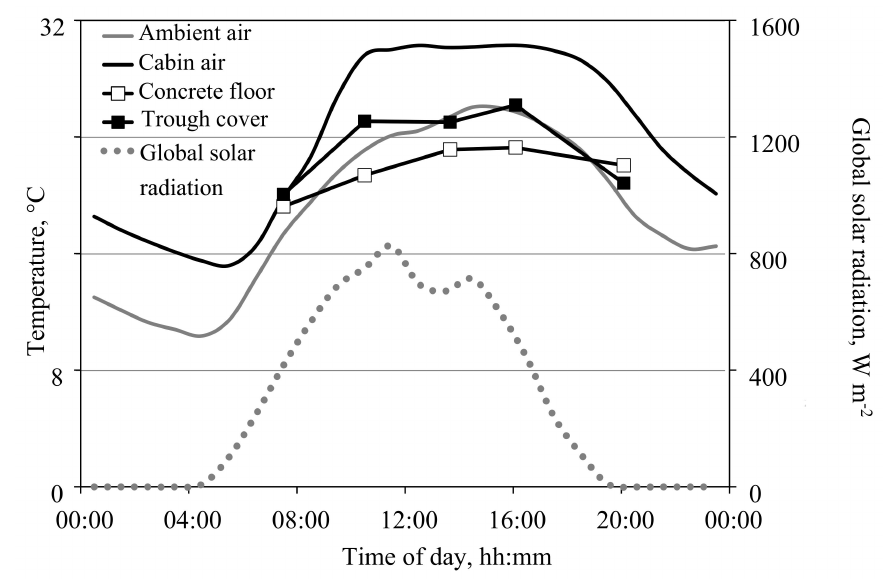
Figure 5. Daily courses on 11 May 2016 of global radiation outside the greenhouse and temperatures of the cabin and ambient air, the concrete cabin floor, and the chipboard covers of the root troughs. The latter two were measurements from six points in two rows each using a handheld infrared thermometer, while the others were records from the greenhouse computer. The setpoints for heating the greenhouse air during the night and the day and ventilating the greenhouse were 15, 19, and 29 ◦ C, respectively. The temperature in the root troughs was adjusted at 19 ◦ C. The supply air rate was 60 and 200 m 3 h − 1 during the night and day, respectively. In addition, roof ventilation was open from 10:00 to 17:00. The same pattern of the cabin floor temperatures was obtained when the cabin was cooled by increasing the supply air rate with increasing cabin temperature and roof ventilation remained closed.